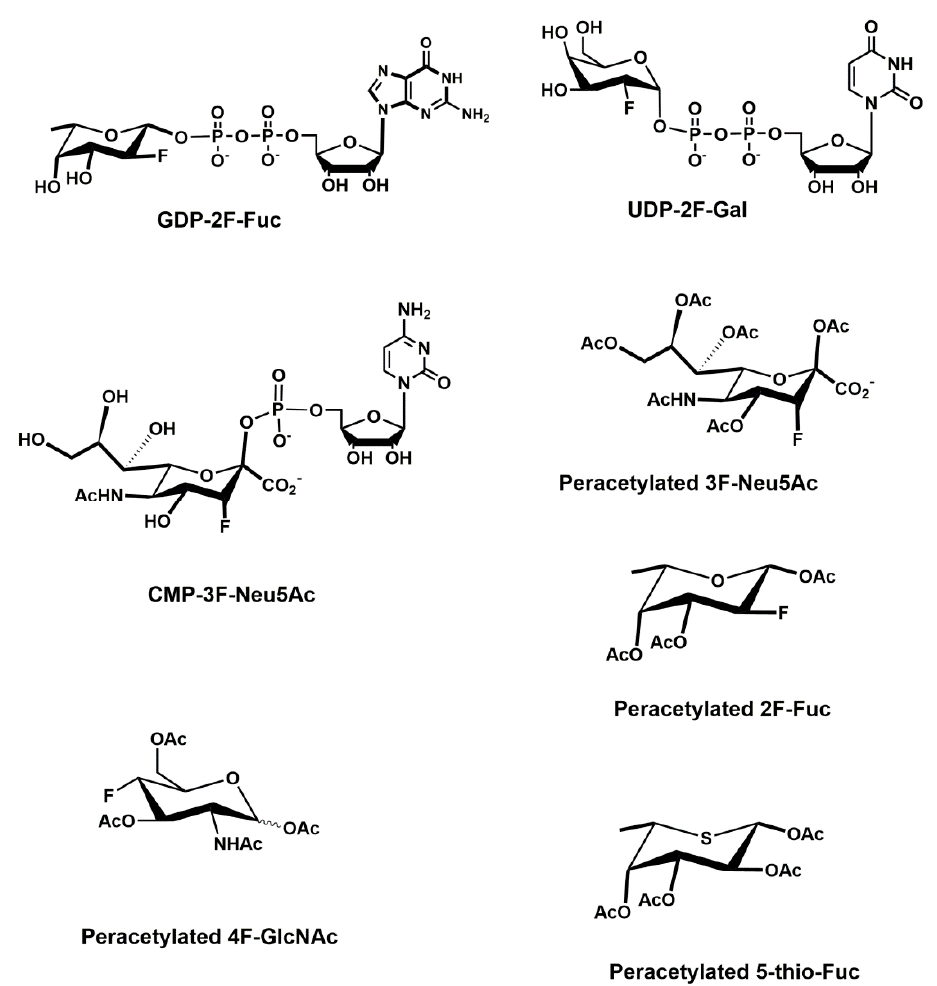
Figure 17. Schematic representation of fluorinated derivatives of donor-based inhibitors.